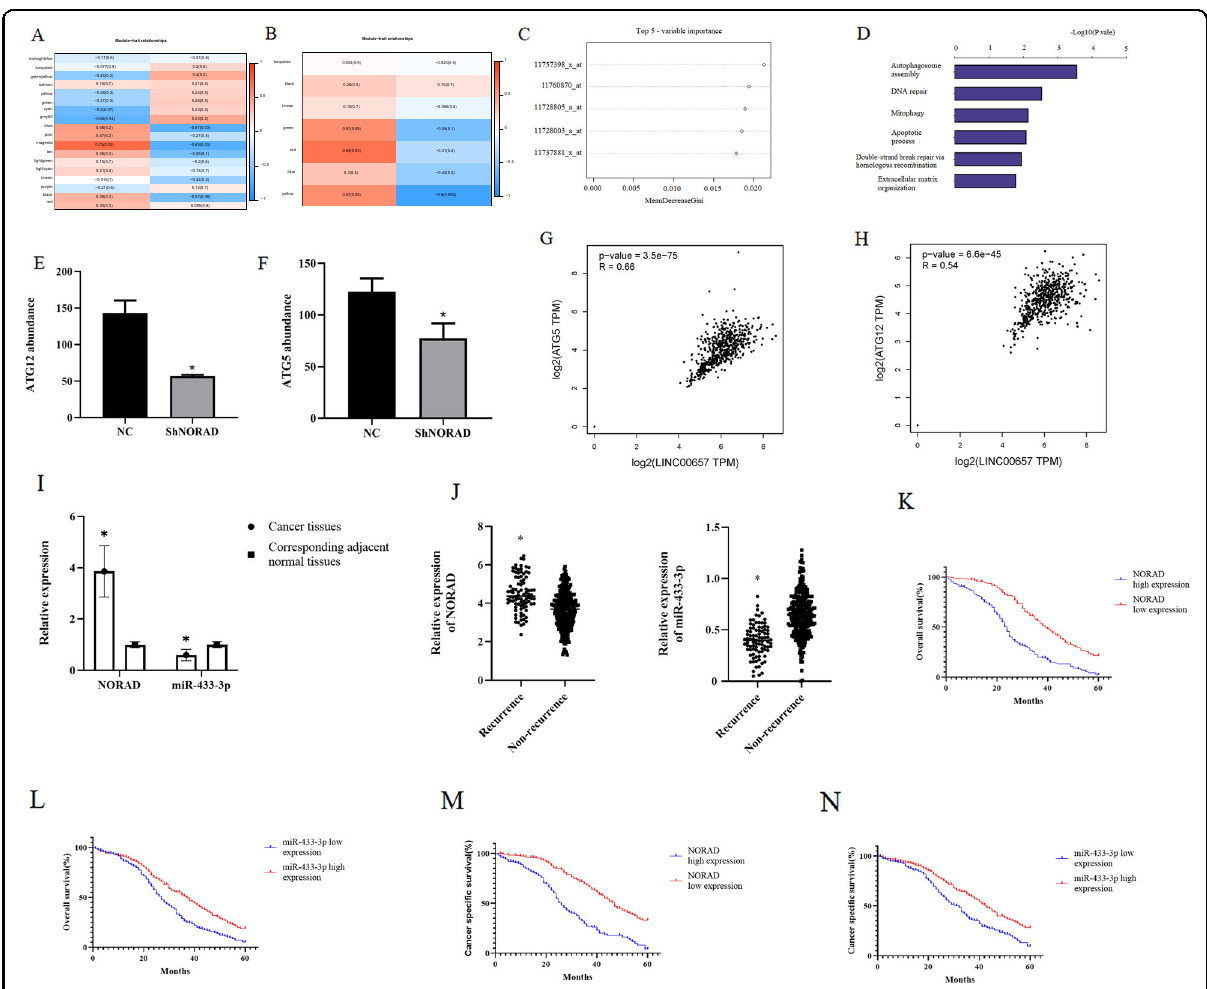
Fig. 2 NORAD was identi fi ed to be involved in DNA damage and autophagy. A WGCNA for the relationship between gene modules and clinical traits. B WGCNA for the relationship between microRNA modules and clinical traits. C Top fi ve genes ranked by importance based on random-forest model. D GO biological process pathways involved for differentially expressed genes after NORAD knockdown using TMT-based quantitative proteomic analysis in SGC-7901 and SGC-7901-R cell lines. E The in fl uence of NORAD knockdown on ATG12 abundance using TMT-based quantitative proteomic analysis between SGC-7901 and SGC-7901-R cell line ( t = 6.721, P < 0.000). F The in fl uence of NORAD knockdown on ATG5 abundance using TMT-based quantitative proteomic analysis between SGC-7901 and SGC-7901-R cell line ( t = 4.032, P < 0.000). G The association between NORAD and ATG5 based on TCGA and GTEx data. H The association between NORAD and ATG12 based on TCGA and GTEx data. I The expression of NORAD ( t = 6.538, P < 0.000) and miR-433-3p ( t = 4.276, P < 0.000) in 379 gastric cancer patients. J The expression pro fi le of NORAD ( t = 2.817, P = 0.003) and miR-433-3p ( t = 2.175, P = 0.008) in nonrecurrent and recurrent gastric cancer patients. K – N The overall survival and cancer- speci fi c survival for NORAD (OS, χ 2 = 65.28, P < 0.000, 2K; CSS, χ 2 = 61.06, P < 0.000, 2M) and miR-433-3p (OS, χ 2 = 20.56, P < 0.000, 2L; CSS, χ 2 = 16.92, P < 0.000, 2N) in 379 gastric cancer